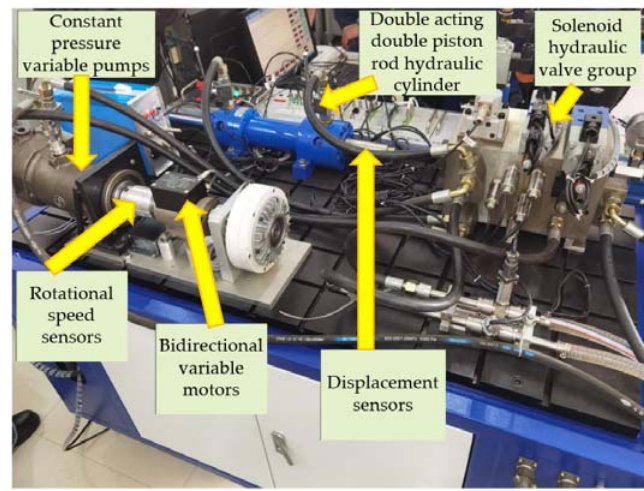
Figure 7. Real photo of the PMSS test bench. Table 6. The technical specification of the main measuring equipment.